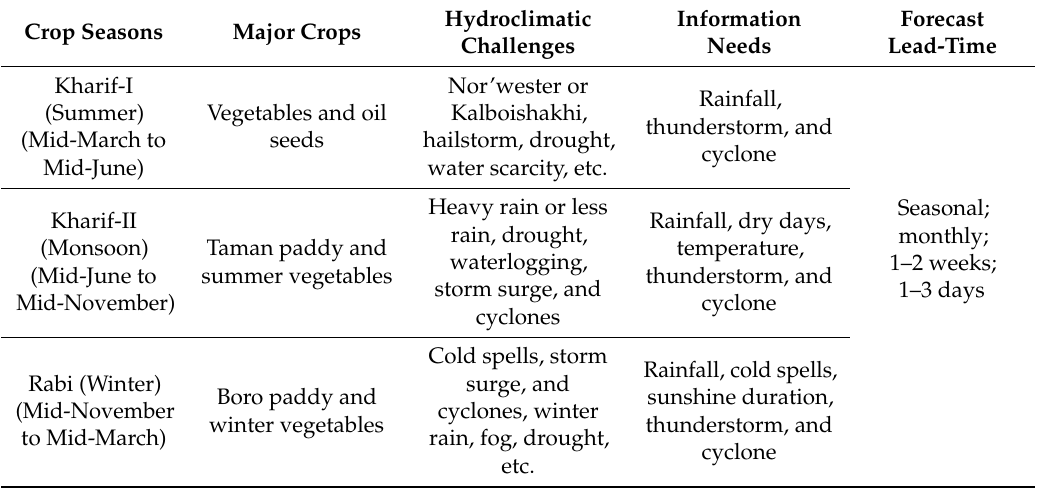
Table 2. Summary of the season-specific hydroclimatic information needs of smallholder farmers in the Lower Bengal